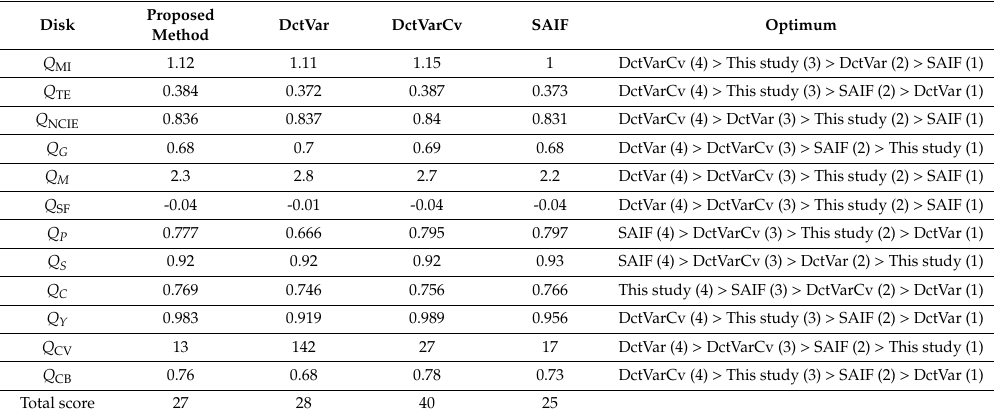
Table 3. List of disk fusion results and fusion quality indicators.